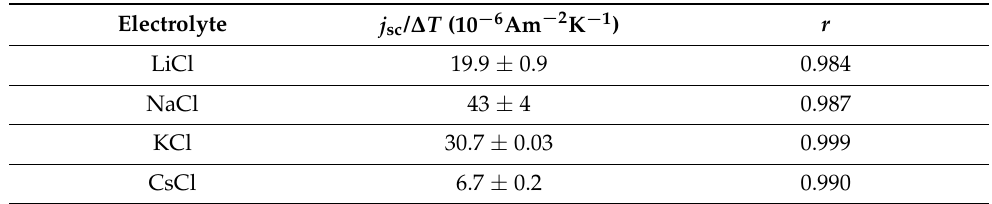
Table 3. Short circuit density per K of temperature difference for the different electrolytes. Values correspond to linear fits of the experimental data shown in Figure